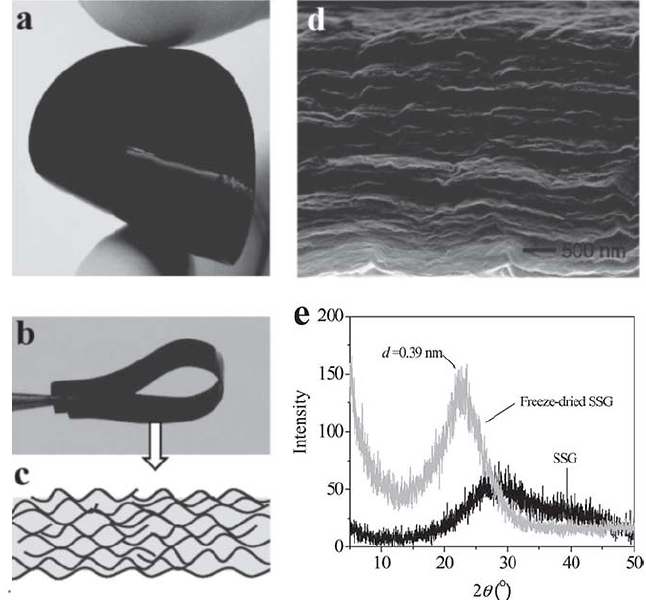
Figure 10. ( a ) and ( b ) Photographs of the as-formed flexible self-stacked solvated graphene films; ( c ) Schematic illustration of the cross-section of a solvated graphene film; ( d ) SEM image of the cross-section of a free-dried solvated graphene film; ( e ) XRD patterns of as-prepared and free-dried solvated graphene films. Reprinted with permission from [32]. Copyright 2011 John Wiley and